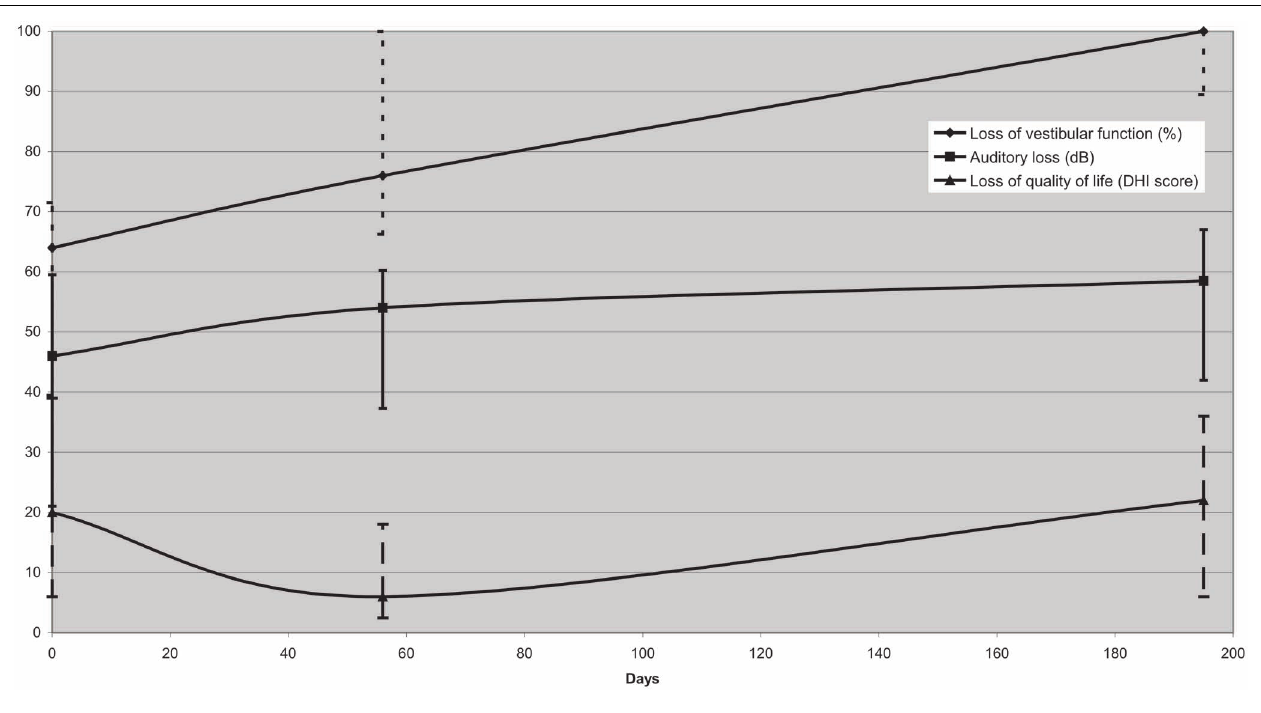
follow-up 1, and follow-up 2 forVS ≥ 20mm (median; interquartile range). Despite a marked deterioration of vestibular function, DHI scores remained relatively